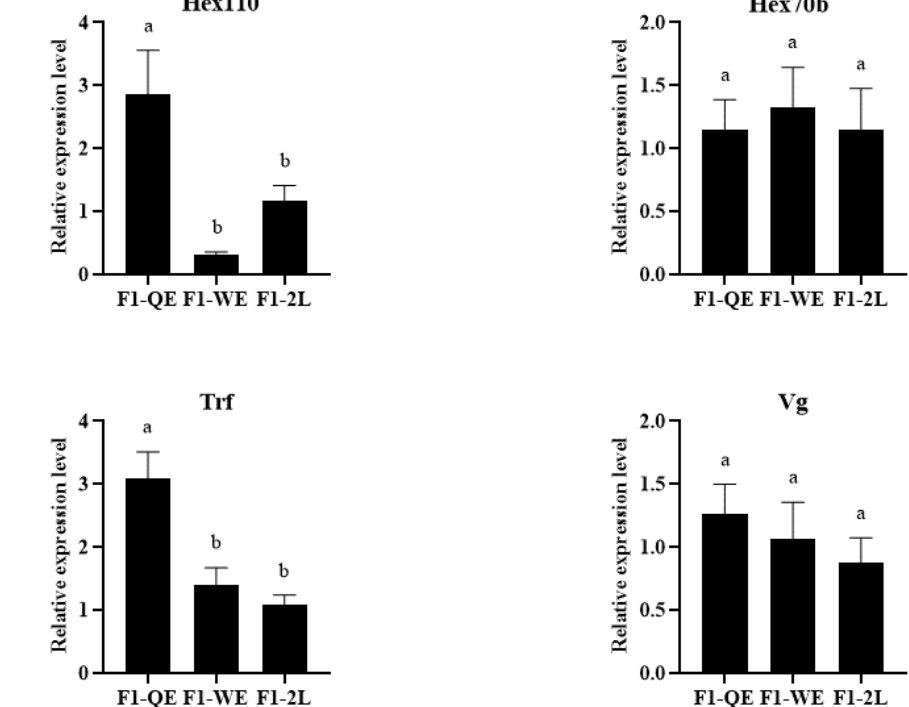
Figure 2. The expression level of development-related genes of F1 queens.Bars show mean ± SE (standard error). Different letters above the bars indicate significant differences between groups ( p < 0.05, one-way ANOVA test followed with Fisher’s LSD